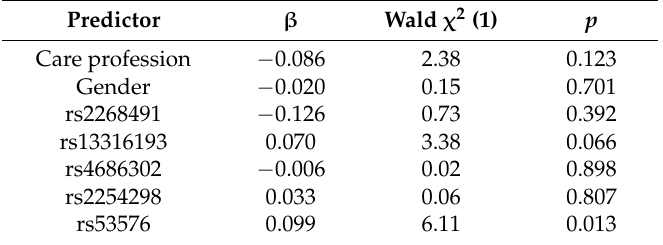
Table 4. Test of model effects, i.e., parameter estimates, dependent variable IAT score. Predictor β Wald χ 2 (1) p Care profession − 0.086 2.38 0.123 Gender − 0.020 0.15 0.701 rs2268491 − 0.126 0.73 0.392 rs13316193 0.070 3.38 0.066 rs4686302 − 0.006 0.02 0.898 rs2254298 0.033 0.06 0.807 rs53576 0.099 6.11